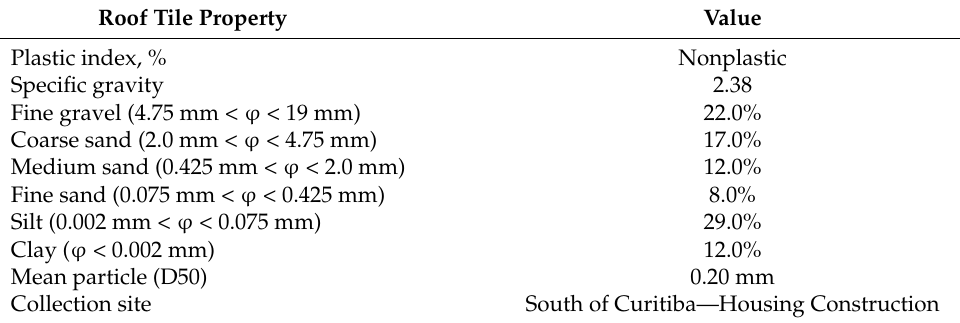
Table 4. Physical properties of the roof tile